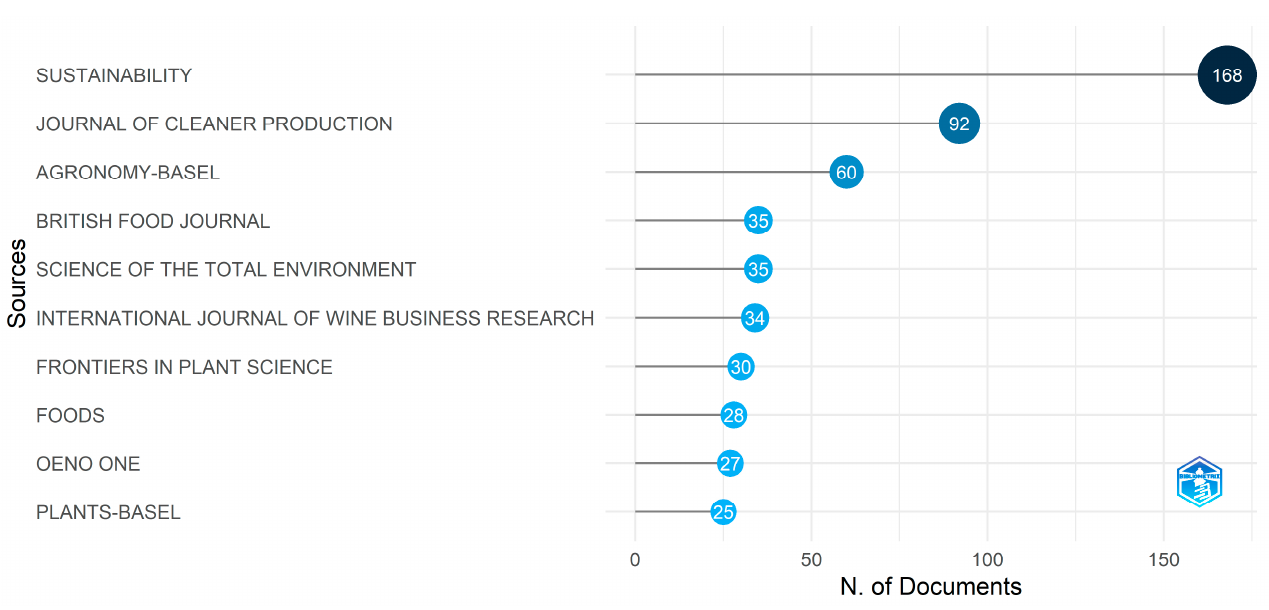
Figure 3. Leading journals per number of publications in sustainability of the vine and wine industry.